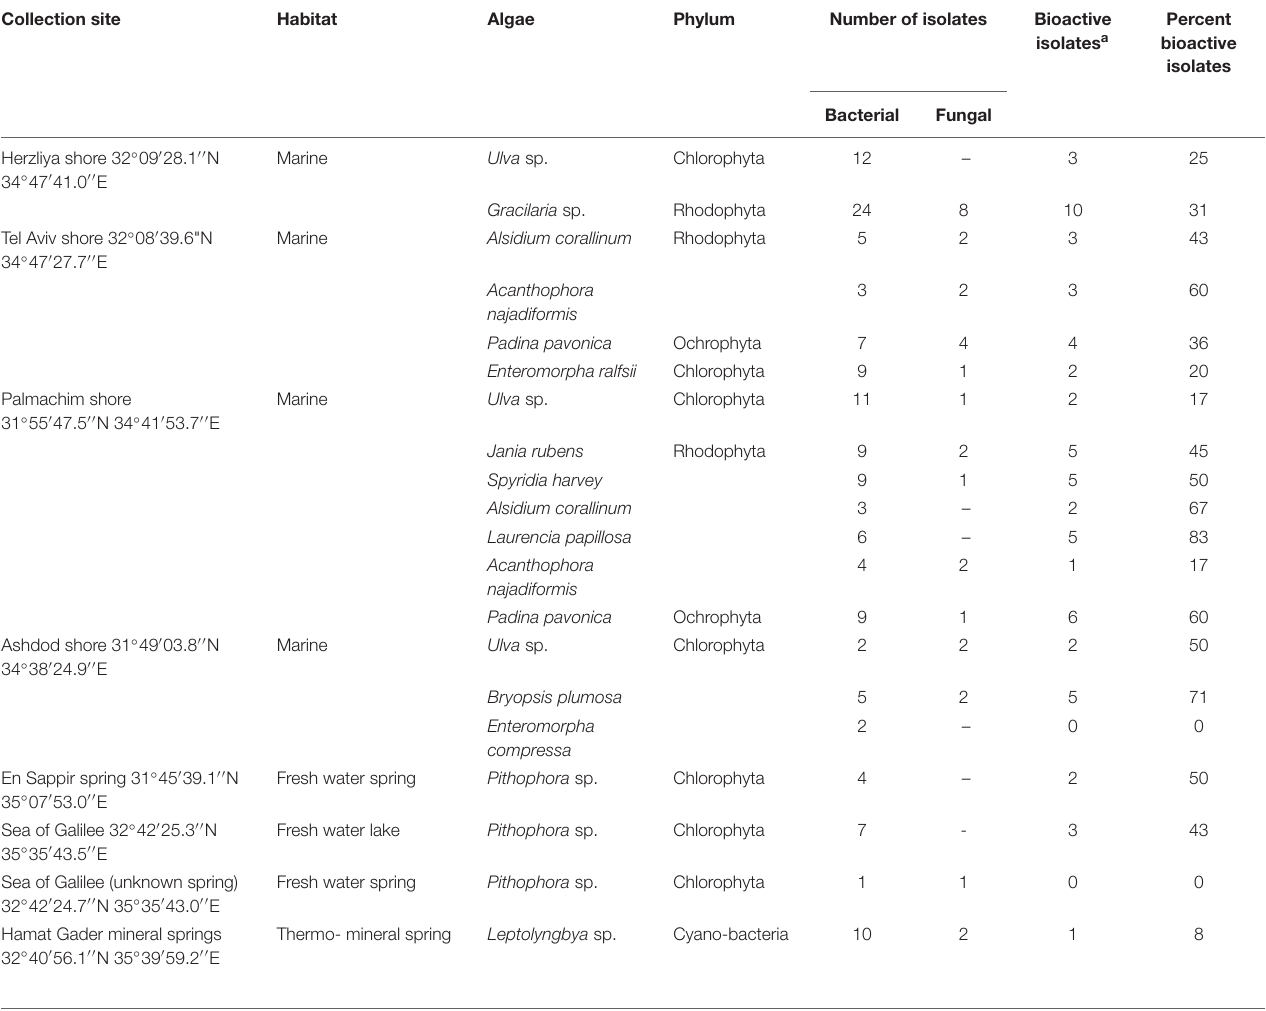
TABLE 1 | Algae and isolated endophytes from different water sources in Israel, with percentage of bioactive isolates. Collection site